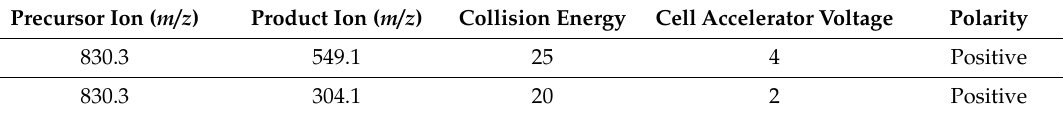
Table 1. Multiple reaction monitoring (MRM) transitions of docetaxel sodium adduct, used in method A. Precursor Ion ( m / z ) Product Ion ( m / z ) Collision Energy Cell Accelerator